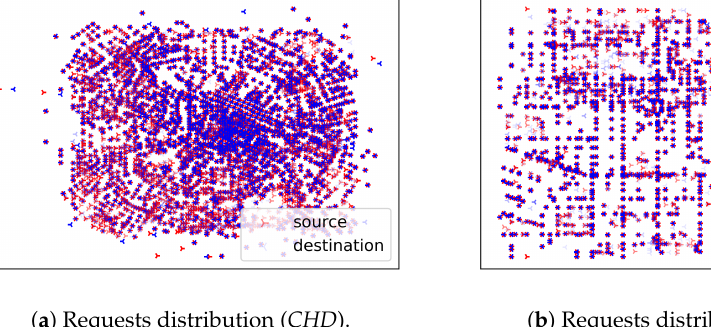
Figure 4. The distribution of the testing